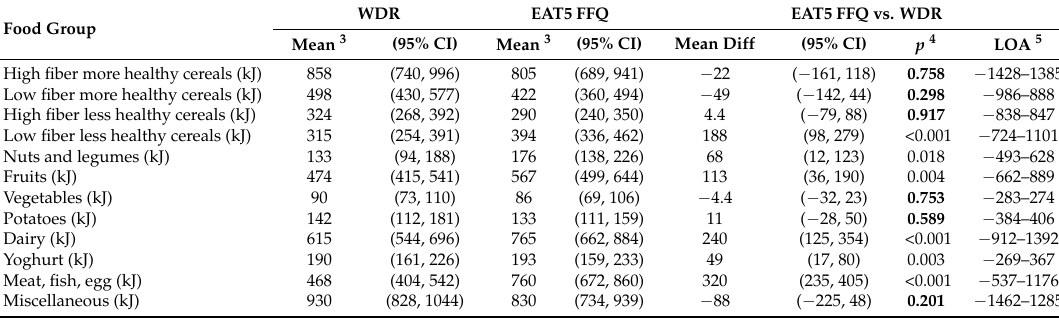
Table 5. Mean daily intake, mean difference and limits of agreement for food groups (energy contribution) of relevance to the gut microbiota according to WDR and EAT5 FFQ in 5-year old children ( n = 100) 1,2 .